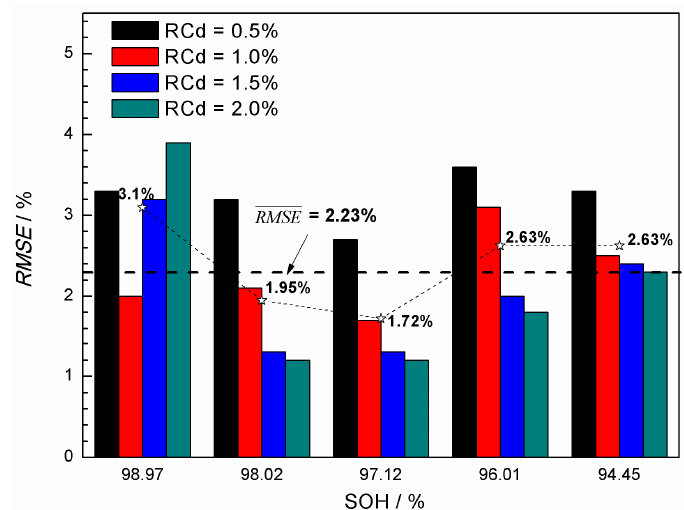
Figure 7. Prediction RMSE for a Ni-MH battery in the charge-discharge test at 0.5C using ( C discharge , Δ V charge ) data groups at different state-of-health (SOH) with different RCds.